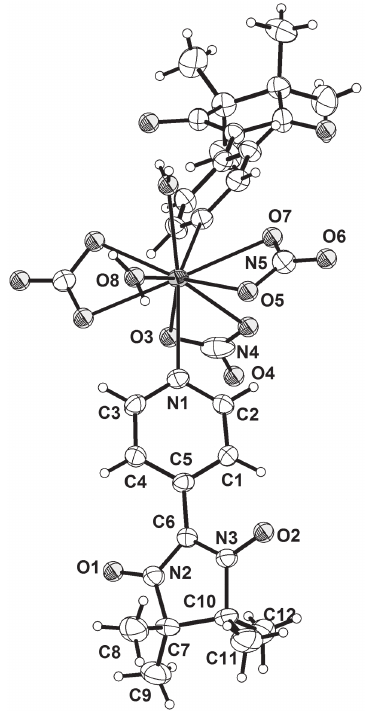
Table 1: Data collection and